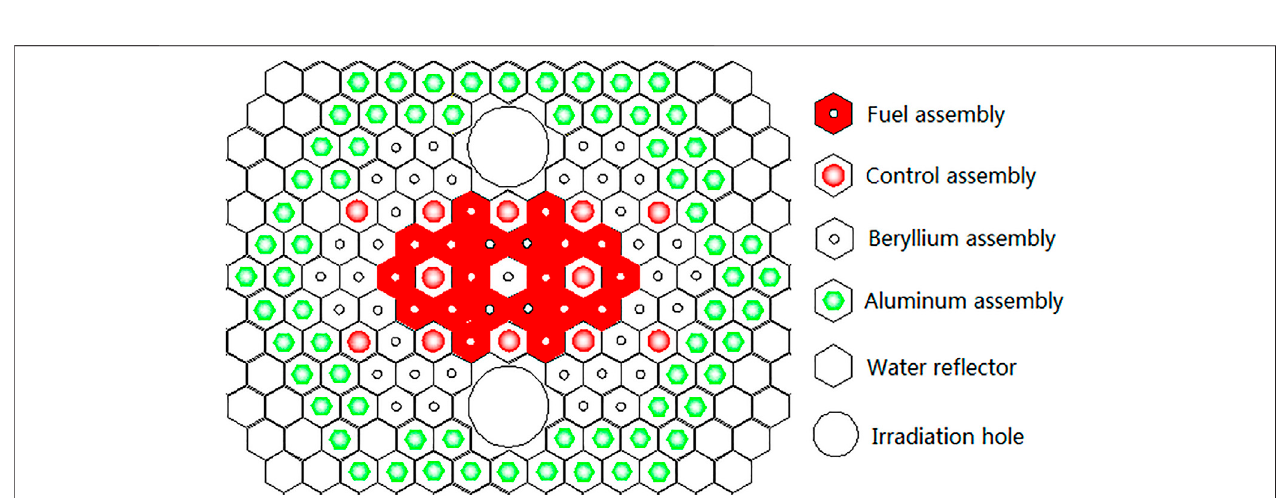
FIGURE 9 | Core arrangement of Scheme 9.